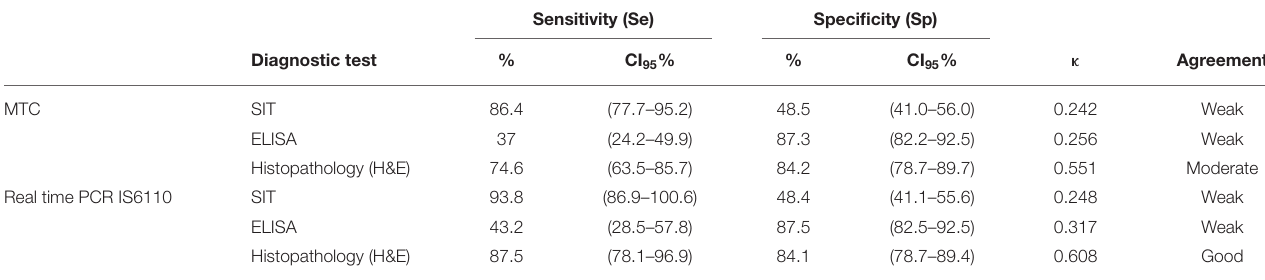
TABLE 7 | Estimates of sensitivity and specificity of the diagnostic techniques compared to against MTC culture as gold standard either alone or in parallel combination together with real-time PCR targeting IS 6110 .